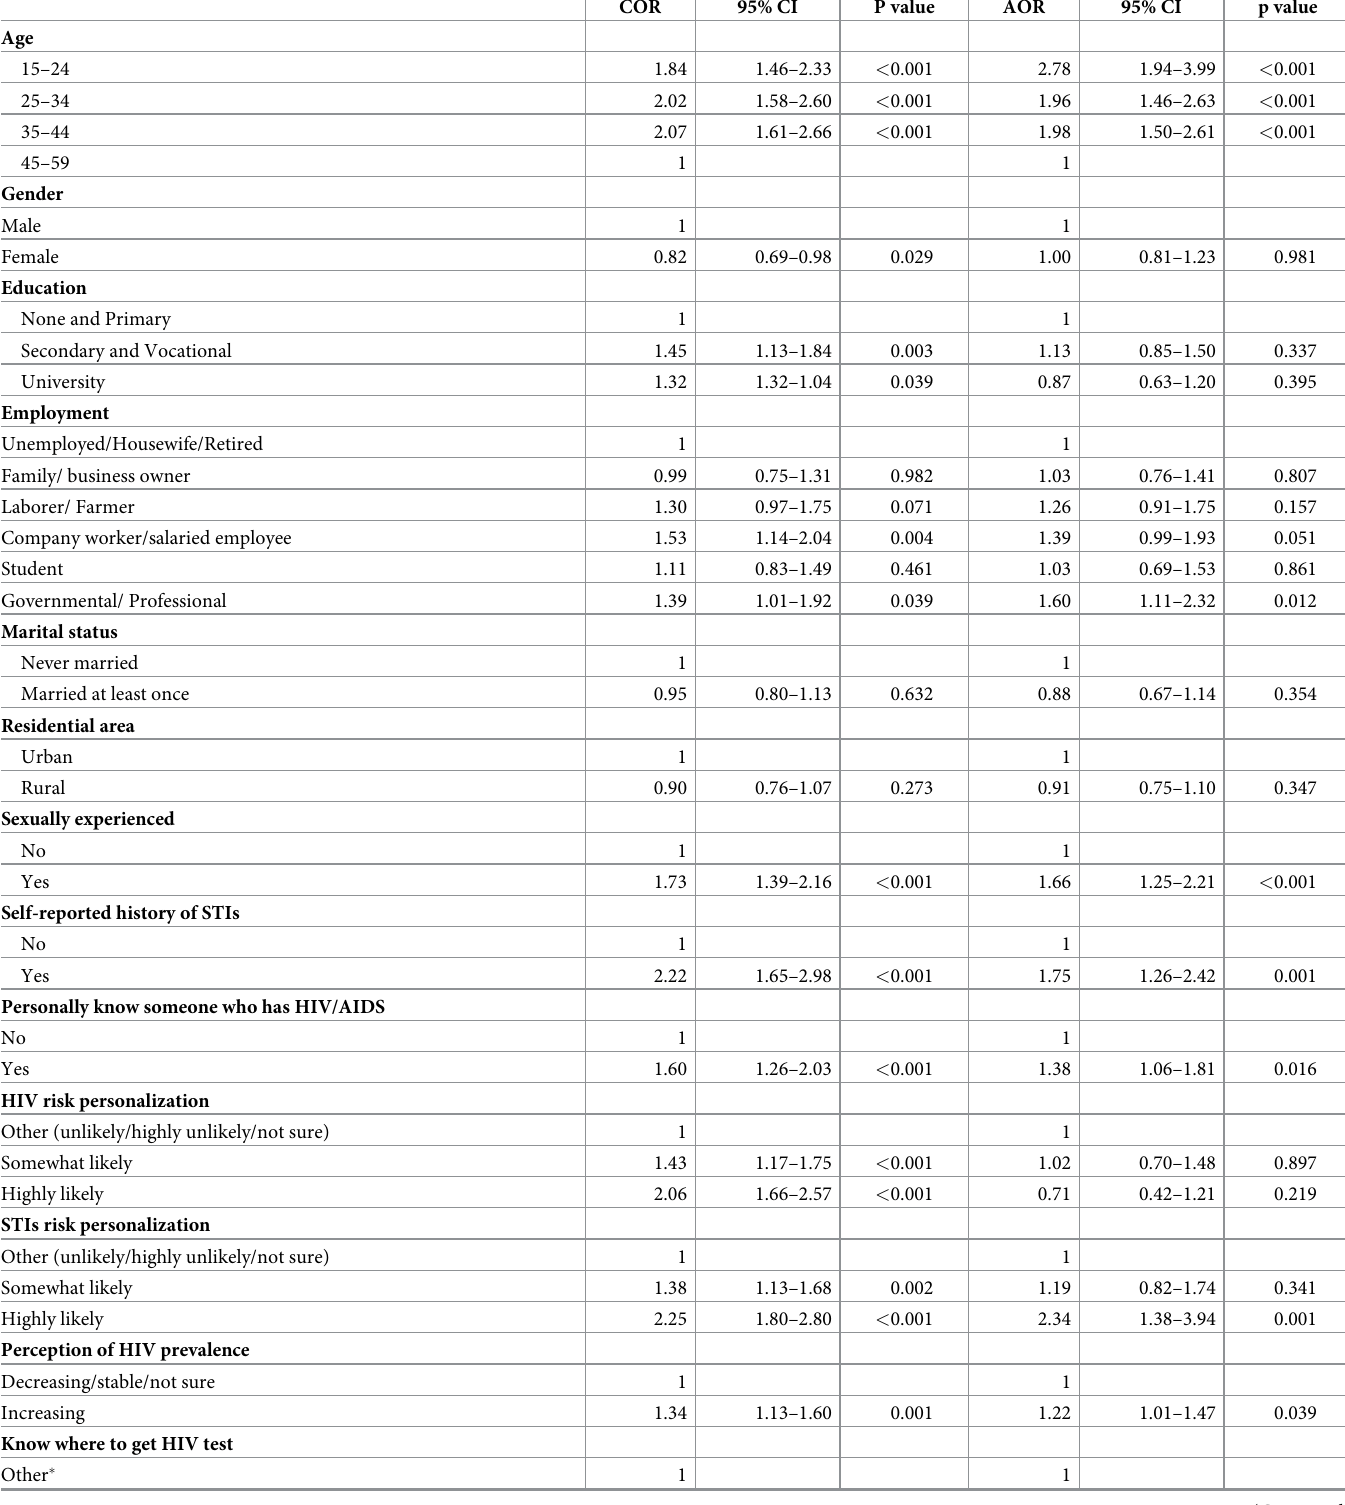
Table 4. Bivariate and multivariable logistic regression of factors associated with intention to test for